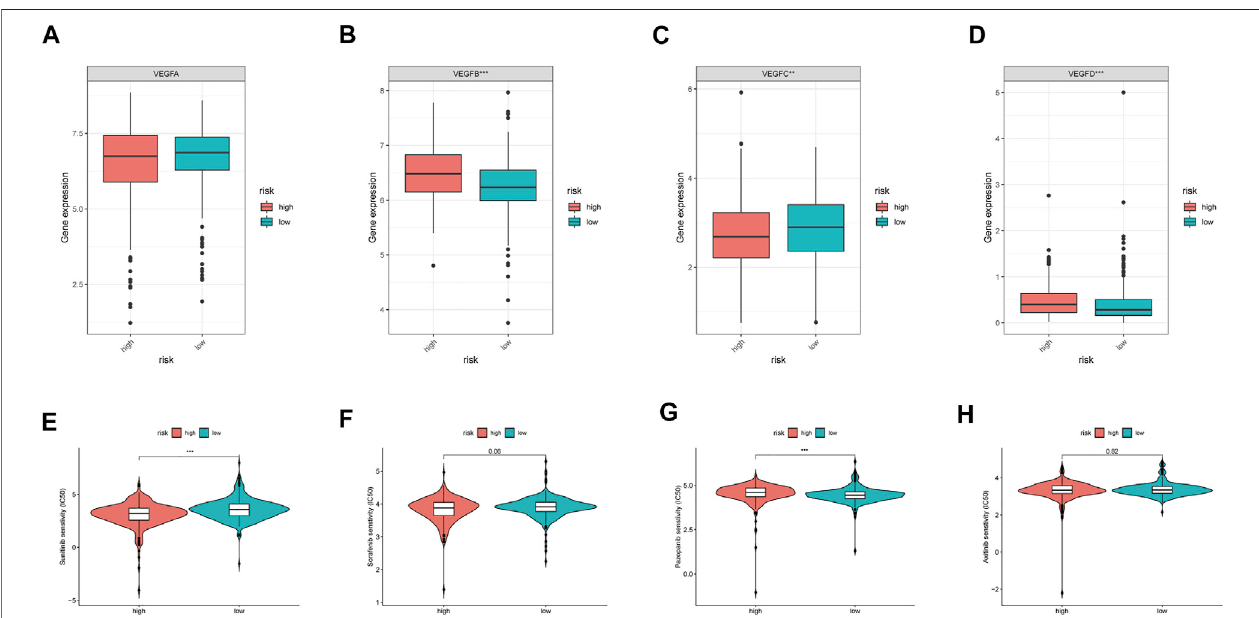
FIGURE 7 | VEGF family expressions and the sensibility of TKI inhibitors in different MRGPS subgroups. (A – D) VEGF family expressions in different MRGPS subgroups. Drug susceptibility analysis between different MRGPS subgroups about (E) Sunitinib, (F) Sorafenib, (G) Pazopanib, (H) Axitinib. Wilcoxon test (ns, p > 0.05;